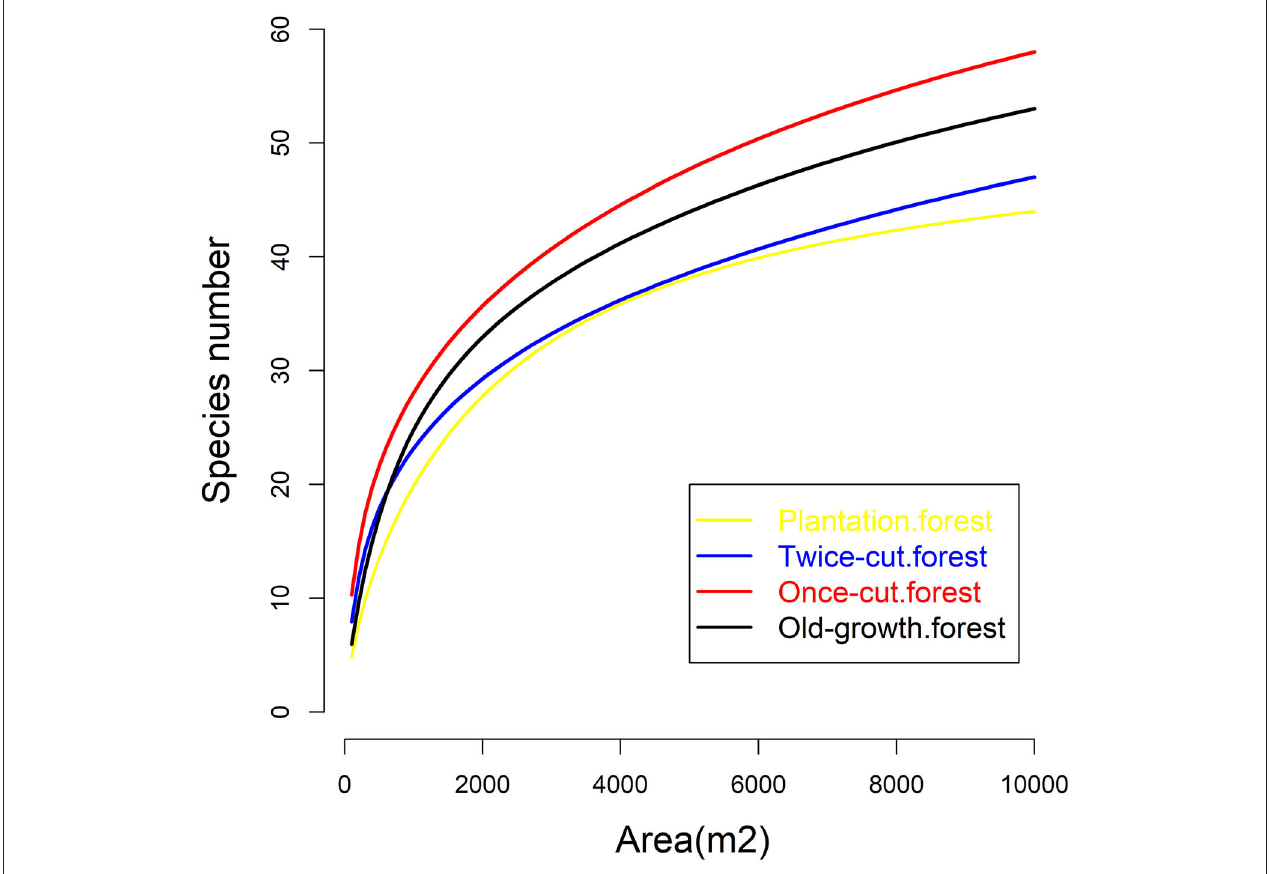
FIGURE 3 | Species area curves of the four